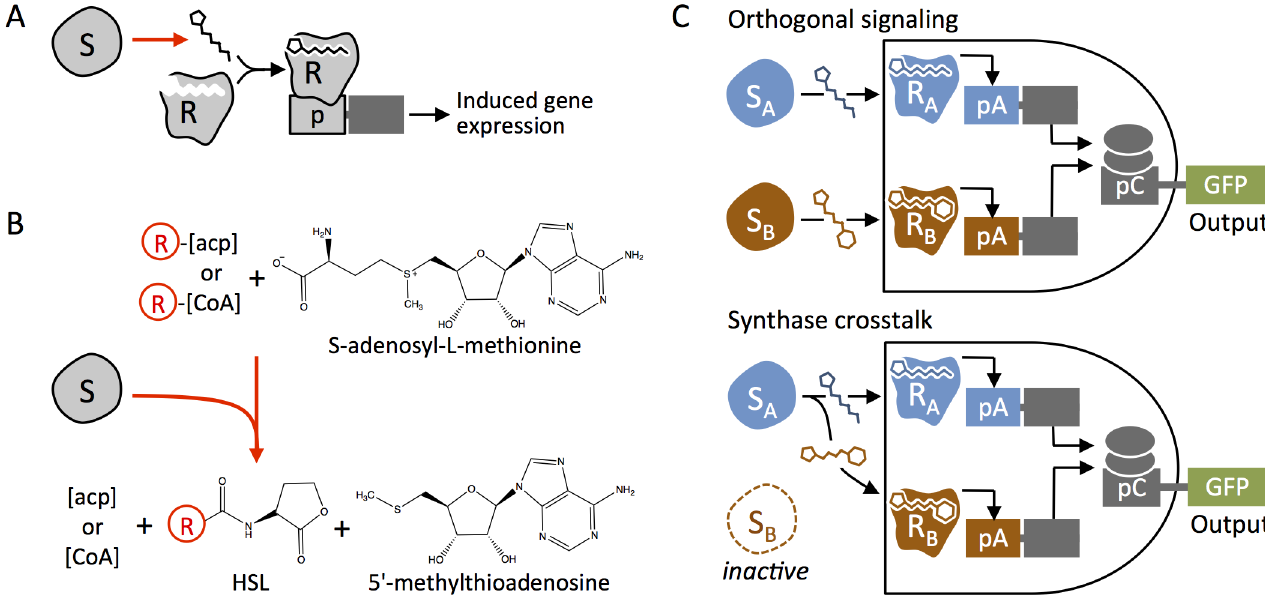
Fig 1. Homoserine lactone (HSL) function, production, and role in quorum sensing crosstalk. (A) Synthase protein (S) catalyzes formation of the HSL species. Regulator protein (R) complexes with the HSL ligand and binds to the promoter, which induces expression of downstream genes. (B) Synthase proteins catalyze the production of HSL molecules by facilitating lactone ring formation from S-adenosyl methionine and attaching a variable R-group tail to the lactone ring from one of two donors, acyl-carrier proteins (ACP) or coenzyme A (CoA). (C) The cartoon illustrates an example of the consequence of crosstalk. Two pathways, S A > R A and S B > R B are designed to operate in parallel as a Boolean AND gate sensor. When each synthase generates a single predominant HSL, the output indicates the activity of both S A and S B as intended. However, if S A produces high levels of primary and secondary products that stimulate both R A and R B , a fault occurs where output is produced although the AND condition is not